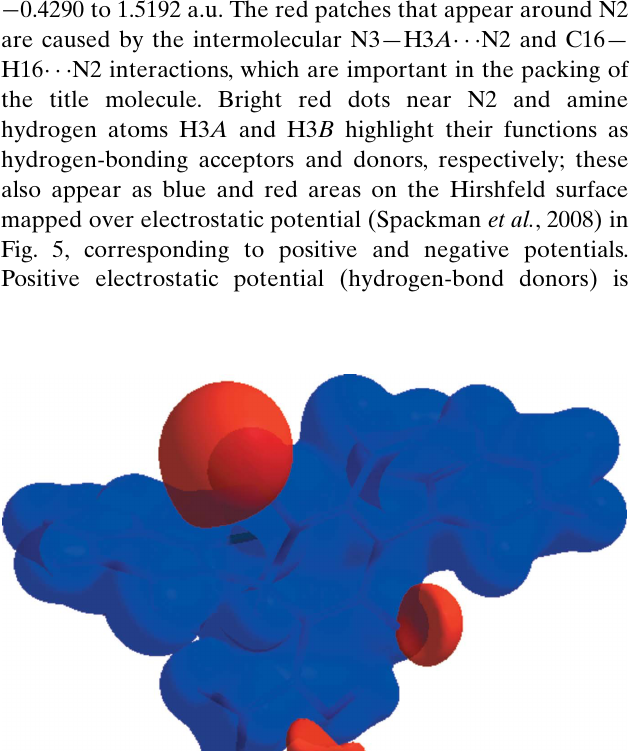
Figure 6 The two-dimensional fingerprint plots of the title compound, showing ( a ) all interactions, and delineated into ( b ) H (cid:2)(cid:2)(cid:2) H, ( c ) C (cid:2)(cid:2)(cid:2) H/H (cid:2)(cid:2)(cid:2) C, ( d ) Cl (cid:2)(cid:2)(cid:2) H/H (cid:2)(cid:2)(cid:2) Cl, ( e ) O (cid:2)(cid:2)(cid:2) H/H (cid:2)(cid:2)(cid:2) O and ( f ) N (cid:2)(cid:2)(cid:2) H/H (cid:2)(cid:2)(cid:2) N interactions [ d e and d i represent the distances from a point on the Hirshfeld surface to the nearest atoms outside (external) and inside (internal) the surface,